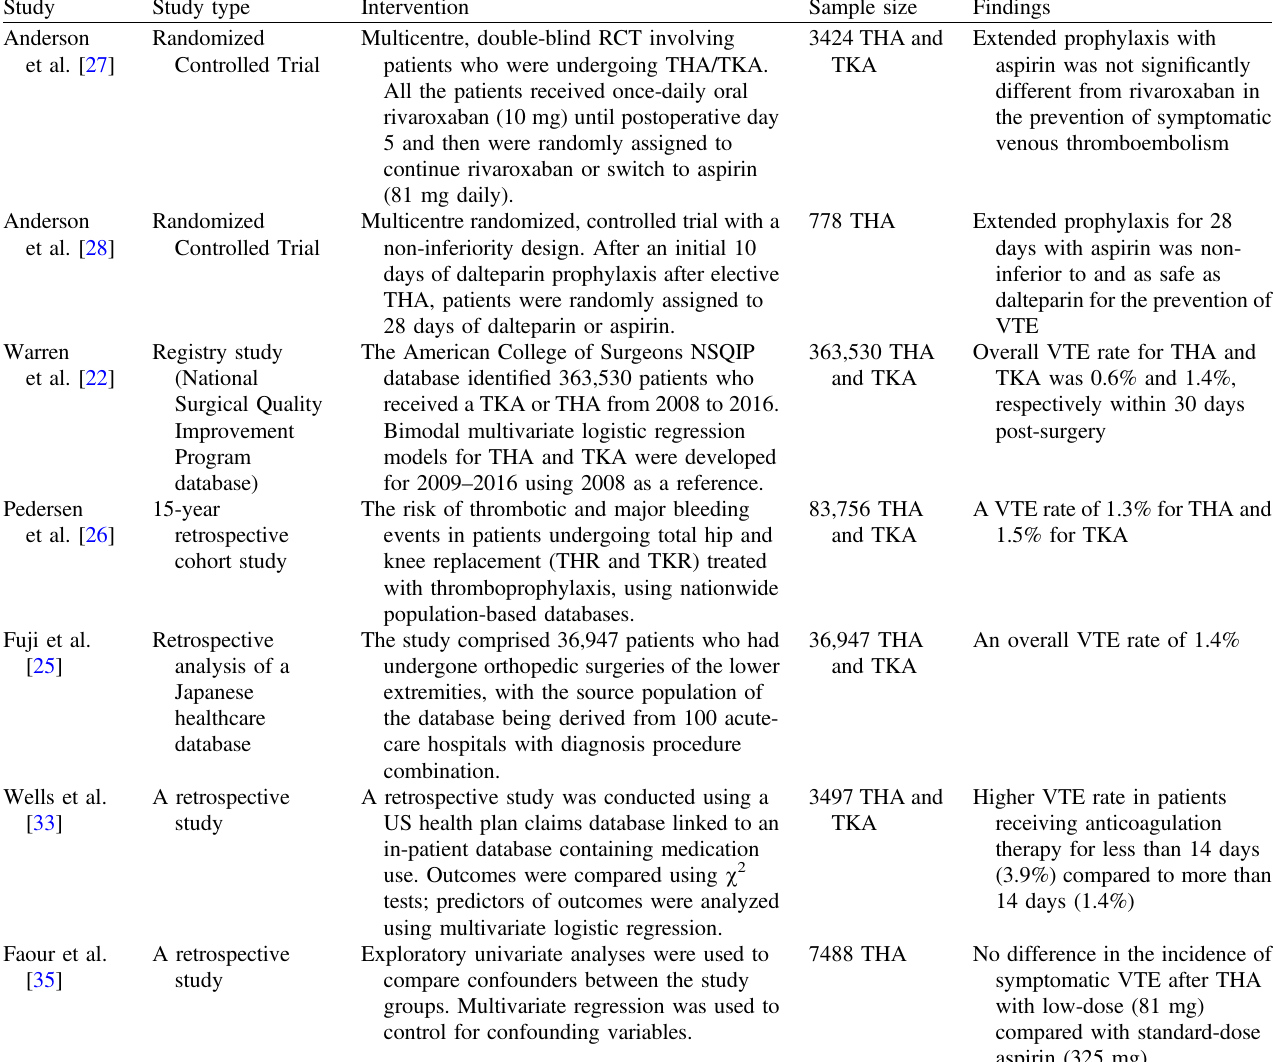
Table 2. Summary of key studies included in the